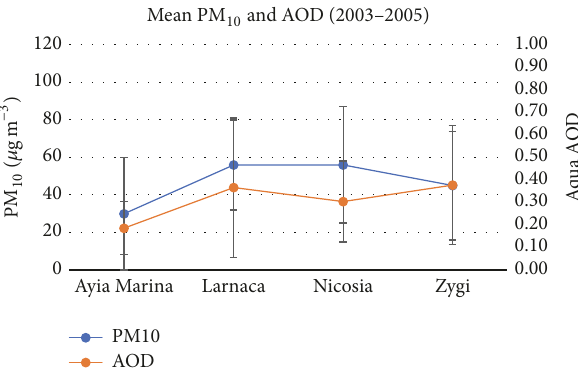
Figure 3: Mean AOD and PM 10 values over the four stations (Ayia Marina, Larnaca, Nicosia, and Zygi) for the period 2003–2005 calculated from the common pairs of the collocated